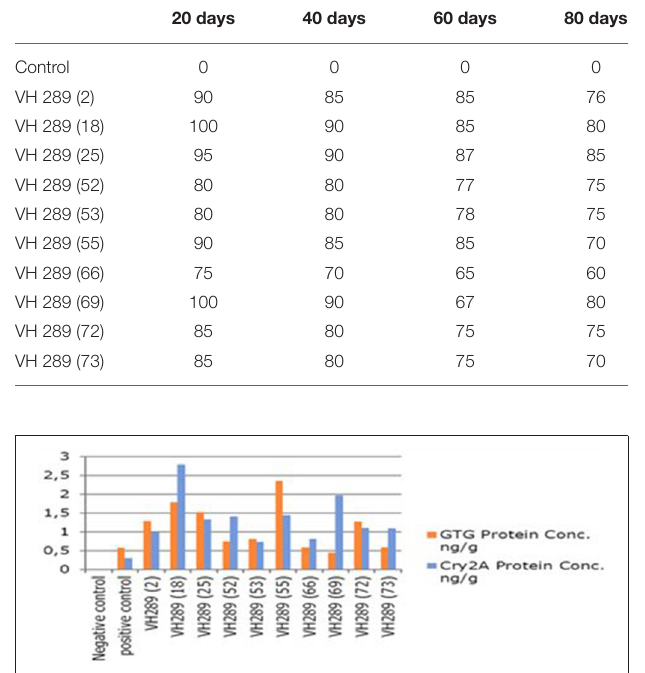
Figure 5 represents the glyphosate positive and control plant spray assay. The results of spray assay are tabulated in Table 7 . Determination of the Copy No. and Location of